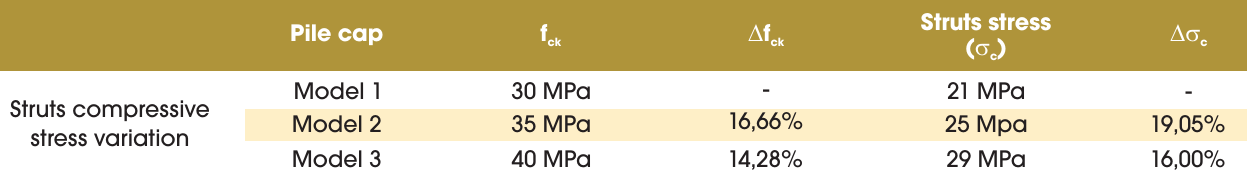
Table 9 – Struts compressive stress variation (  ) in relation to the f